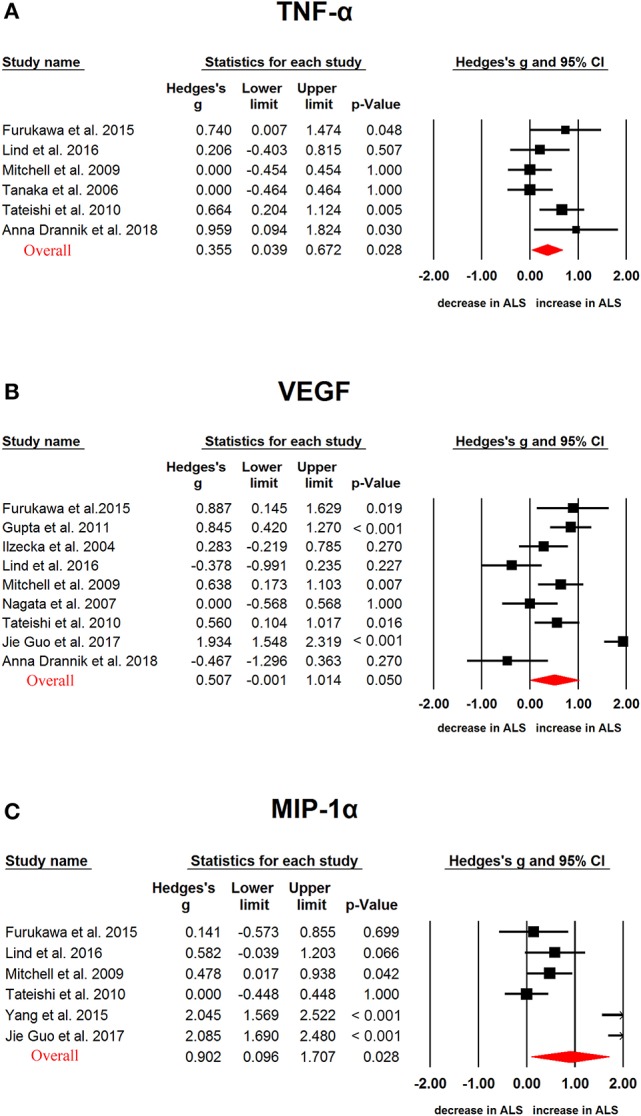
Studies of cerebrospinal fluid TNF-α, VEGF and MIP-1α in Amyotrophic lateral sclerosis. Forest plot displaying random-effects meta-analysis results of the association between TNF-α (A), VEGF (B), MIP-1α (C) and Amyotrophic lateral sclerosis. The sizes of the squares are proportional to study weights.